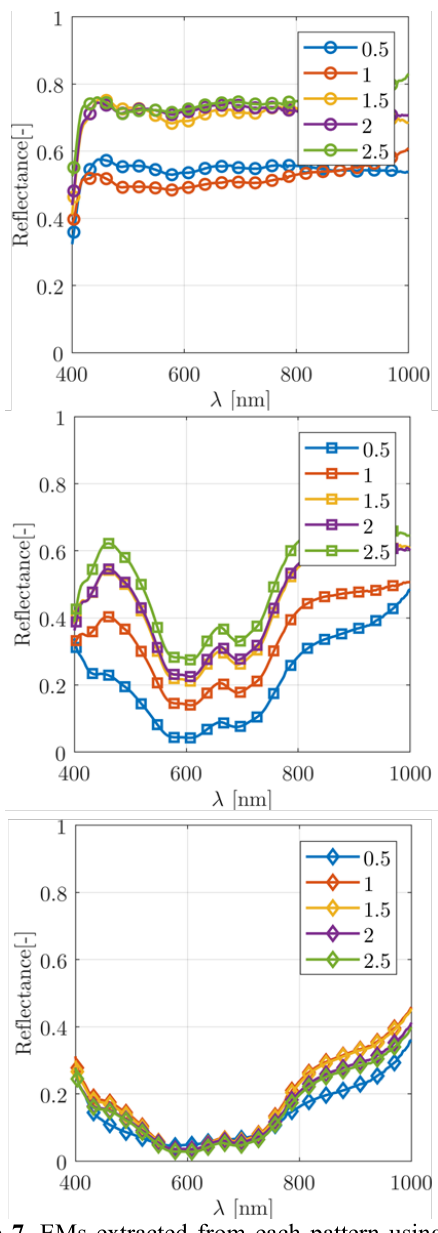
Figure 7. EMs extracted from each pattern using VCA: background (top), cubes (middle), and shadow (bottom).